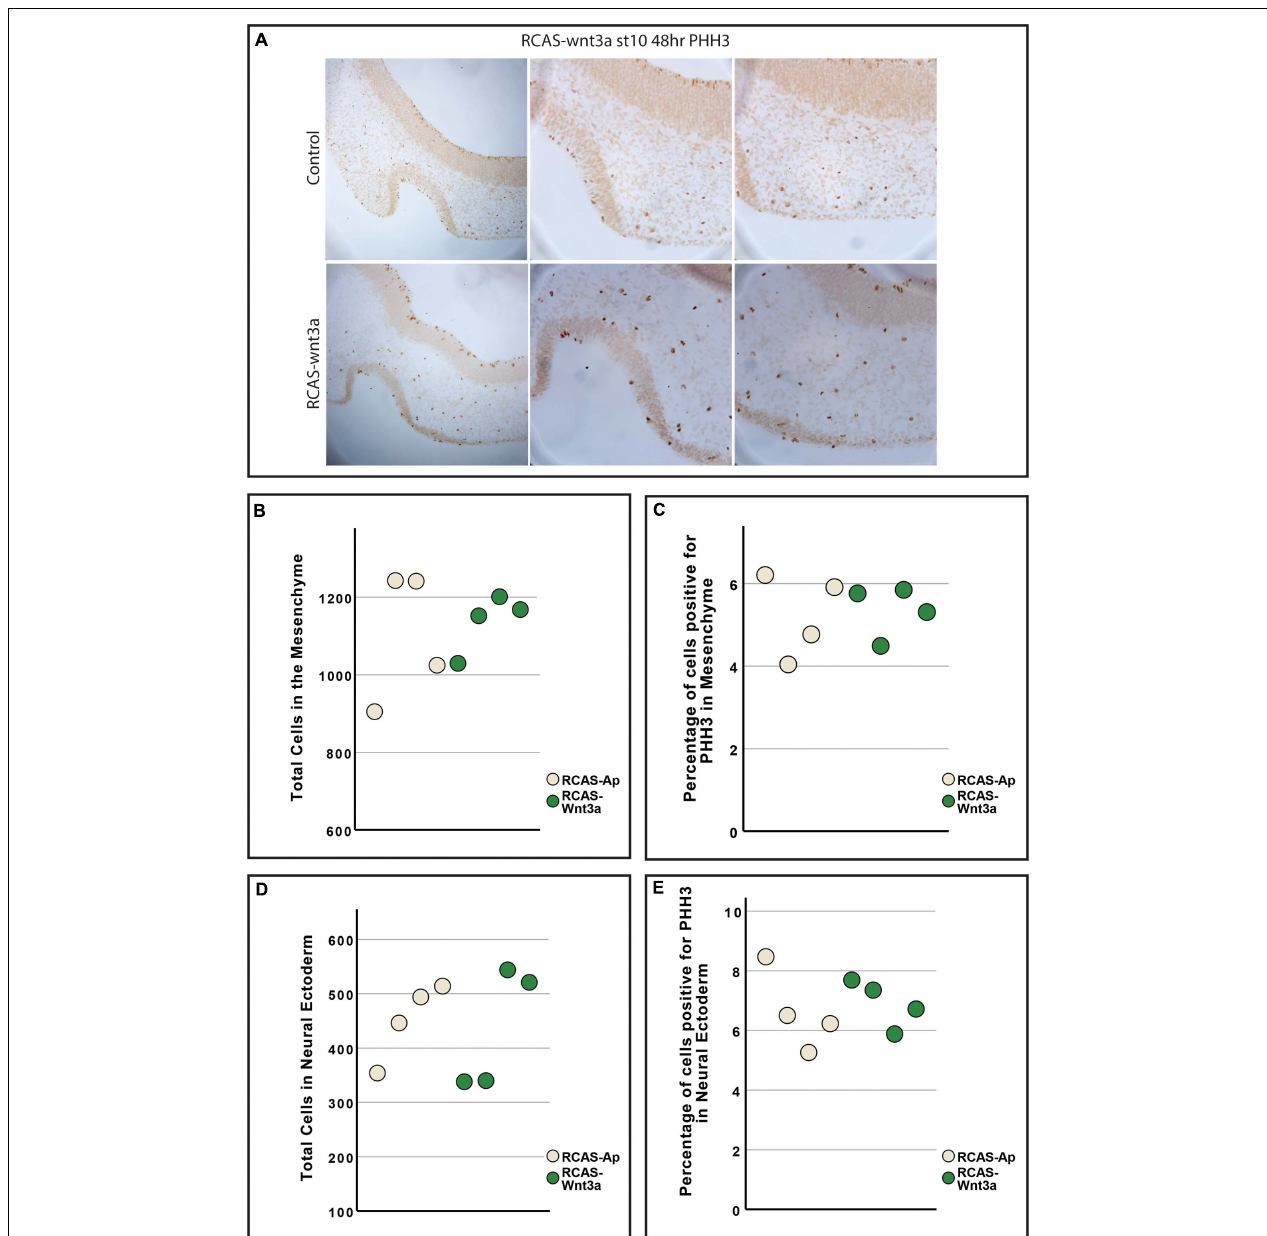
FIGURE 3 | Cell proliferation is unchanged between RCAS-Ap and RCAS- Wnt3a at stage HH22. (A) Immunohistochemistry for phosphohistone H3 (PHH3). Boxplot of total cells (B) and percentage of cells positive for PHH3 (C) in mesenchyme. Boxplot of total cells (D) and percentage of cells positive for PHH3 (E) in neural ectoderm